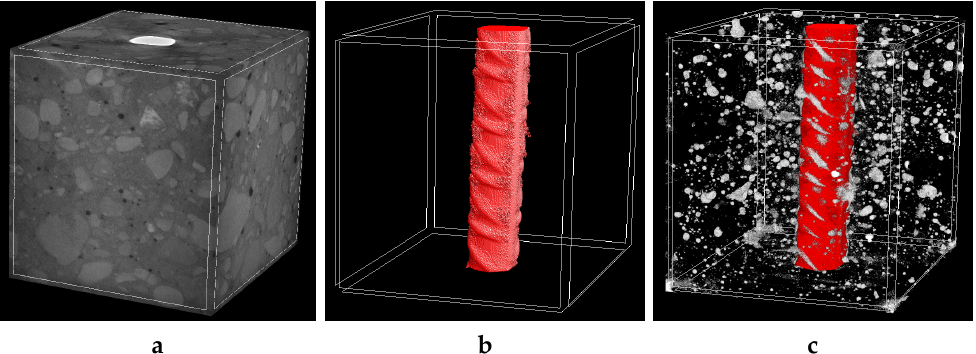
Figure 3. The 3D visualization of reinforced concrete sample no. 1: ( a ) entire sample, ( b ) steel reinforcement bar and ( c ) steel reinforcement bar with air void distribution.